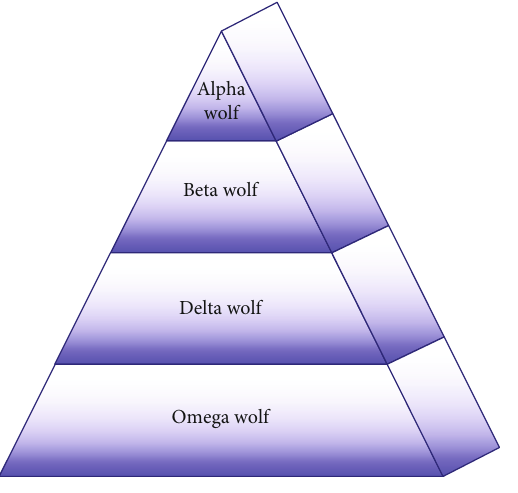
Figure 2: Grey wolf social